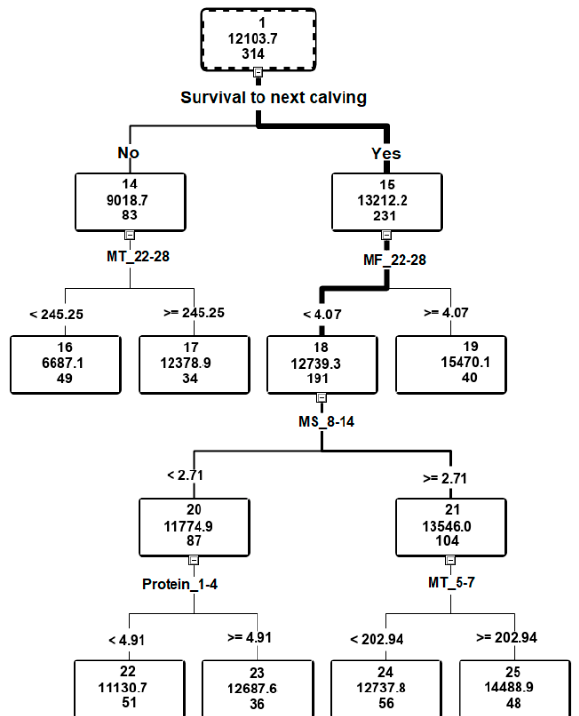
Figure 2. Diagram of decision tree. Abbreviations: MF_22–28—number of milkings/day during 22–28 days of lactation (no./day), MS_8–14—milking speed during 8–14 days of lactation (kg/min), MT_5–7—milk time during 5–7 days of lactation (s/day), MT_22–28—milk time during 22–28 days of lactation (s/day), Protein_1–4—protein content during 1–4 days of lactation (%).